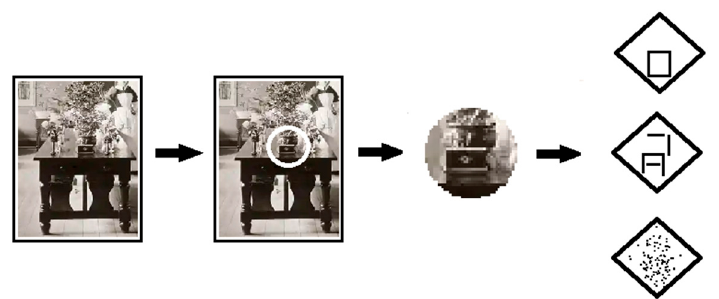
Figure 2. A model for processing of visual objects. The first panel shows a visual scene. The next panel shows an open circle which represents a region with a potential object. The third panel is an enlargement of this region. The final panel contains three open diagonal shapes that are abstract representations of the information in the image. They are ordered from bottom to top by low to high level of abstraction.